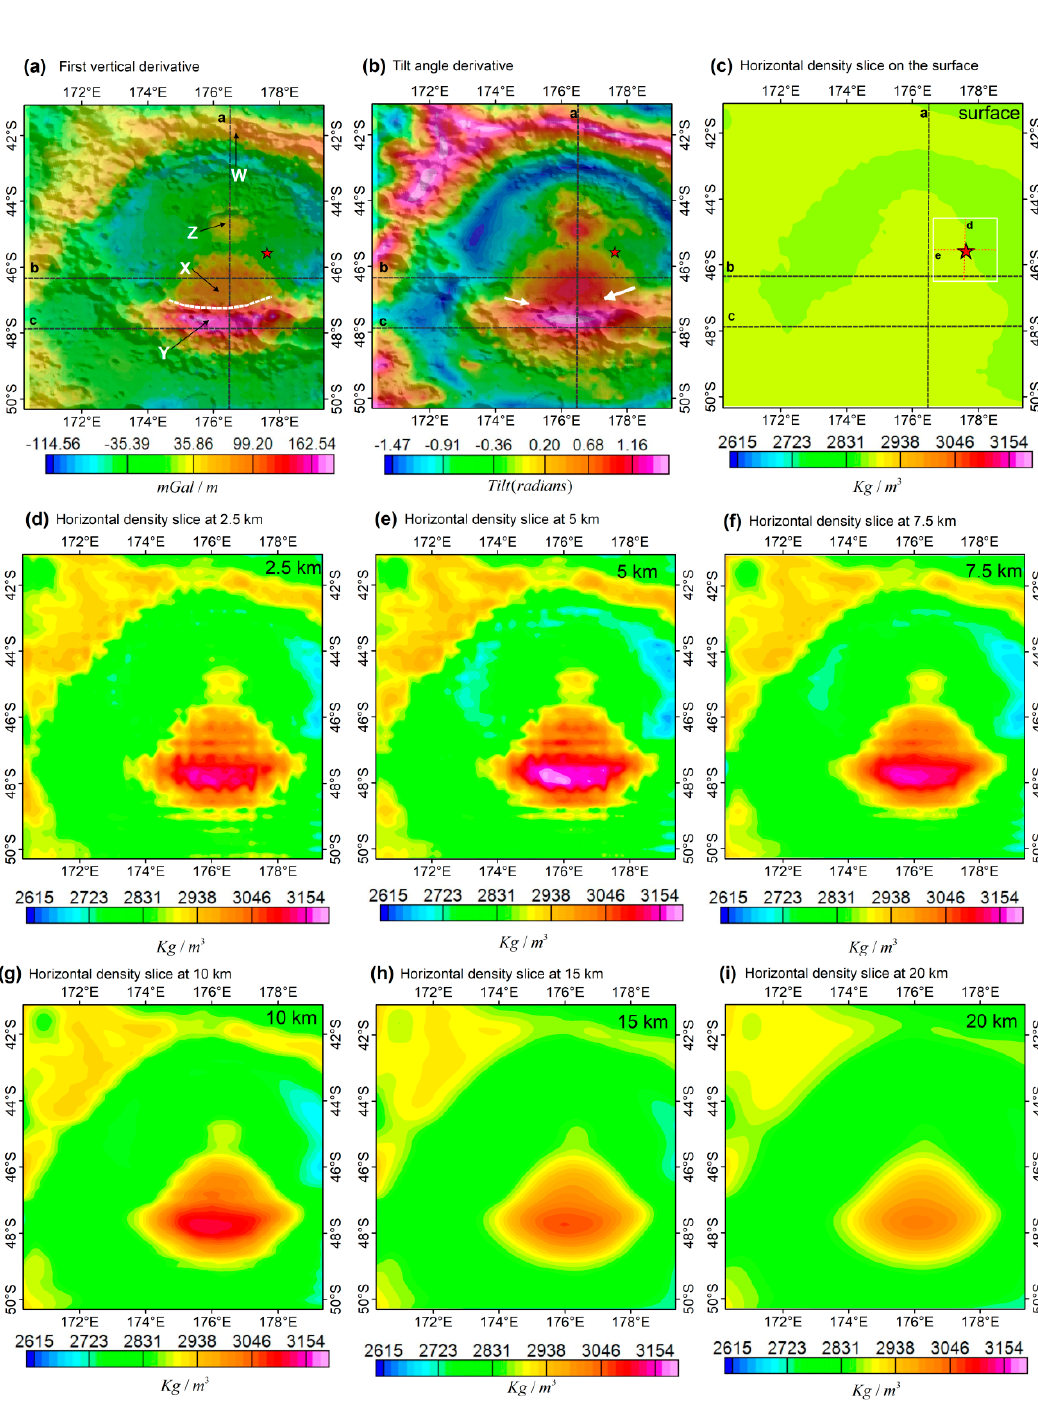
Figure 4. Derivative calculations results draped on a hill-shade topographic map, a-b; ( a ) First vertical derivative. The letters X, Y, Z and W represent anomalous areas in this region. The dashed-white line in Figure 4a represents a possible boundary that separates the high-density region from a relatively low-density region. and ( b ) Tilt angle derivative; and the horizontal density slices c-i, at the depth of ( c ) surface, ( d ) 2.5 km, ( e ) 5 km, ( f ) 7.5 km, ( g ) 10 km, ( h ) 15 km and ( i ) 20 km. The three black lines (a-c) in Figure 4a–c represent the location of the vertical cross-section shown in Figure 5, and the red dashed (d and e) in Figure 4c lines represents the location of the vertical cross-section across the landing site.